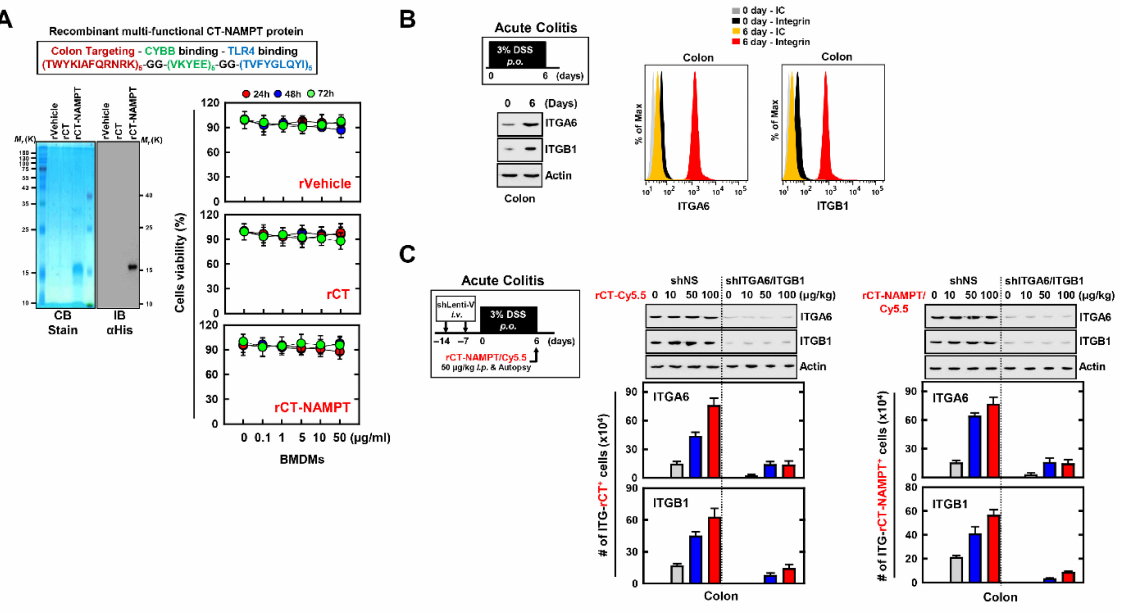
Figure 5. rCT-NAMPT targets the inflamed colon. ( A ) Schematic illustration of rCT-NAMPT (upper). Bacterially purified 6xHis-rCT-NAMPT, rVehicle or rCT were analyzed by Coomassie Blue staining or IB with α His (lower, left). BMDMs were treated with rVehicle, rCT, or rCT-NAMPT for the periods and concentrations stated, and cell viability was determined using the MTT test (lower, right). ( B ) DSS-induced model for colitis. Mice were subjected to 3% DSS for 6 days and were evaluated at day 6 (left). Colon harvests were used for IB with α ITGA6, α ITGB1 or α Actin and analysis of the number of ITGA6+ or ITGB1+ cells by FACS. ( C ) The scheme of the acute colitis model transduced with Lenti-shNS or Lenti-shITG virus and treated with 3% DSS. Intraperitoneal administration of rCT-NAMPT conjugated with Cy5.5 for 1 h and colon harvest (left). Colon harvests were used for